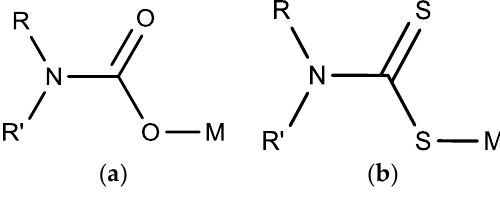
Figure 1. Structure of carbamate ( a ) and dithiocarbamate ( b ).